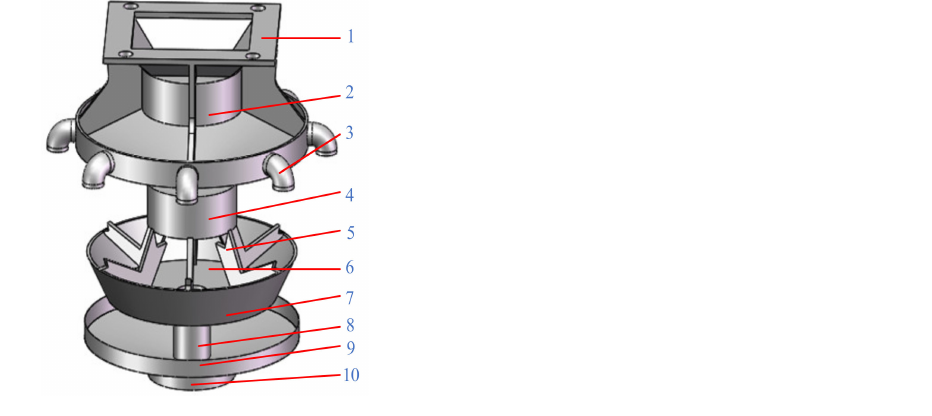
Figure 10. Spirally disturbed vertebral centrifugal fertilizer extractor. 1: Connecting base of fertilizer box; 2: Upper shell; 3: Fertilizer discharge pipe; 4: Spiral disturbance cup; 5: Centrifugal push plate; 6: Fertilizer room; 7: Vertebral disk; 8: Drive shaft; 9: Lower shell; 10: Bearing